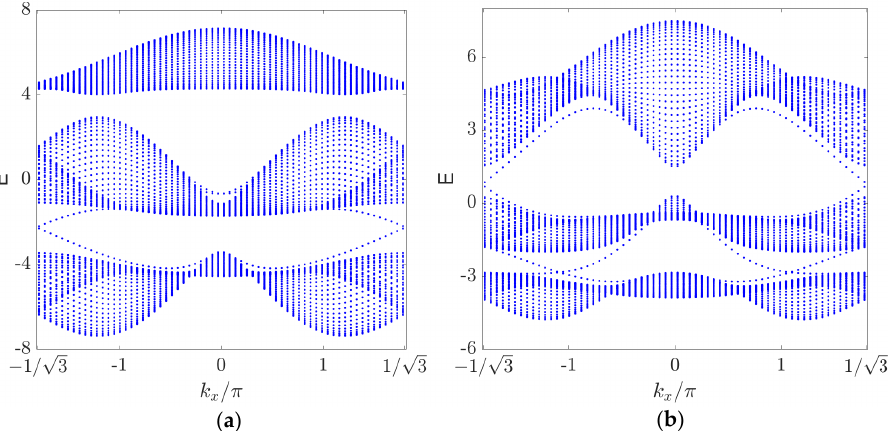
2, φ = 1.5. 2, φ = 1.5. − − = 1, while there are no = 1, while there are no − 3 − = 0; ( b ) ∆ = 1, φ = 1.3. There are 3 = 0; ( b ) ∆ = 1, φ = 1.3. There are − 3 − = 2, and there is only a 3 = 2, and there is only a 3 = 1. 3 = − 3 − 3